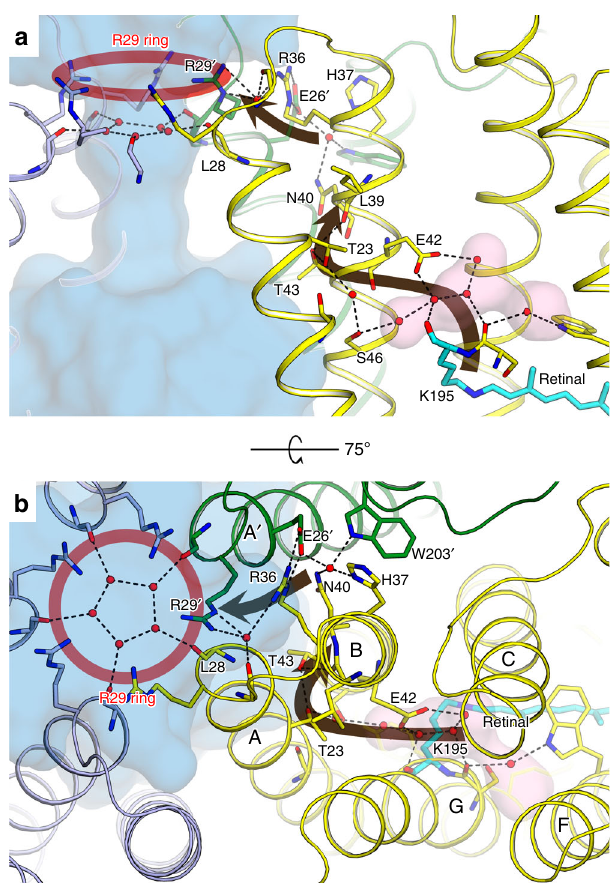
Fig. 4 The cytoplasmic part of OLPVRII and its connection to the central pore. a Side view. One protomer is hidden for clarity. b View from the cytoplasmic side. The central pore is shown with the blue surface. The red circle indicates the R29 ring of the central pore. The brown arrows show the putative sequence of structural rearrangements transduced from RSB to the pore interface. Cavities inside the protein protomer are colored